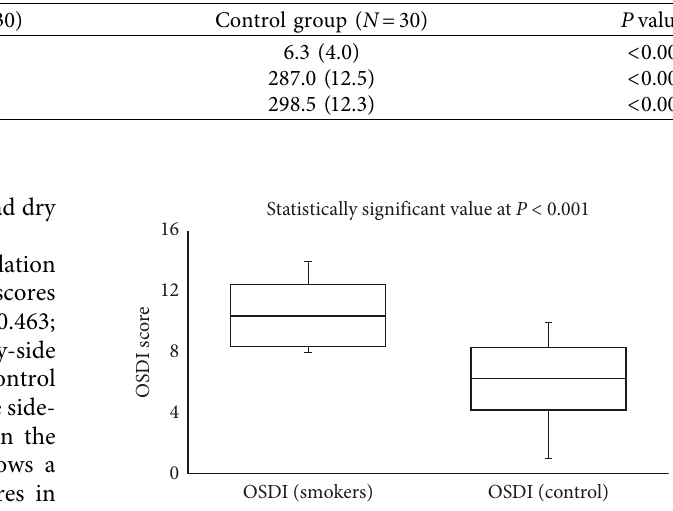
Figure 1: Side-by-side boxplot for OSDI scores for subjects in the study (smokers) and control (non-smokers) groups.